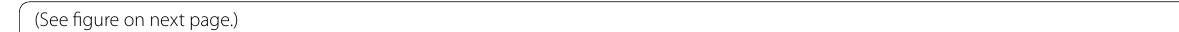
Fig. 7 Expression of inflammatory markers in tenocytes cultured on connective tissue matrices with and without stimulation. The relative expression of inflammatory markers in tenocytes cultured on A-CTM, I-CTM, or TCP in stimulated ( 24 h is shown. The relative expression (fold) of CXCL8 ( A ), TNF ( B ), TGFβ1 ( C ), TGFβ3 ( D ), and MMP1 ( E ) was compared to the mRNA level in tenocytes on Day 0 (starting cells). Data shown are mean